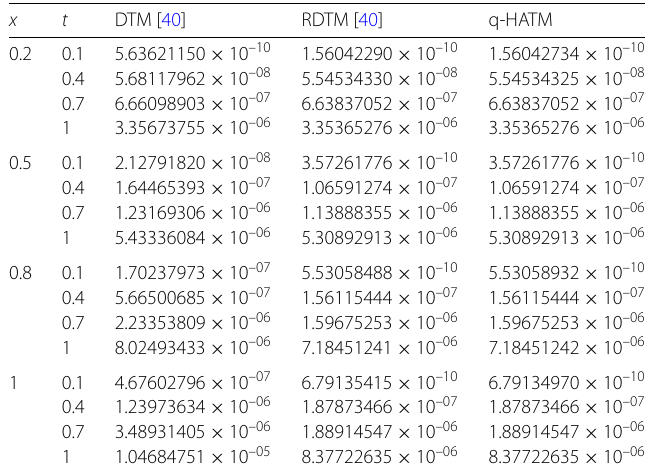
Table 7 The comparison of S (3) solution obtained by DTM, RDTM [40], and q-HATM with the exact solution Equation (32) in terms of absolute error when α = 1, (cid:2) = –1, k = η = 0.1, p = 1.5, r = –1.5, and n = 1 for Example